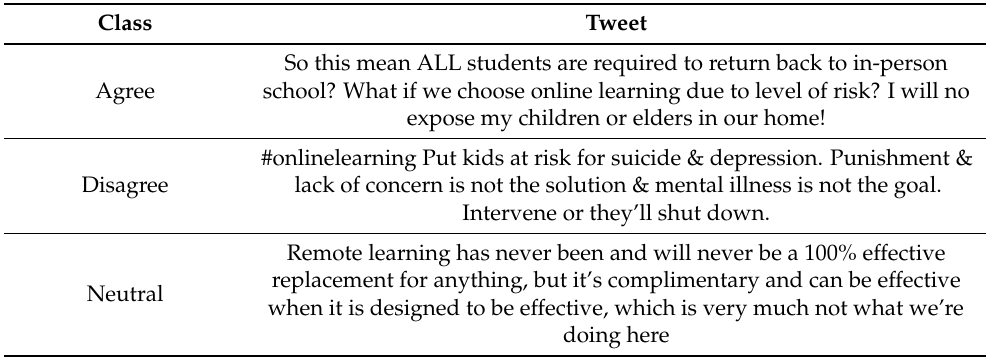
Table 1. Examples of classified